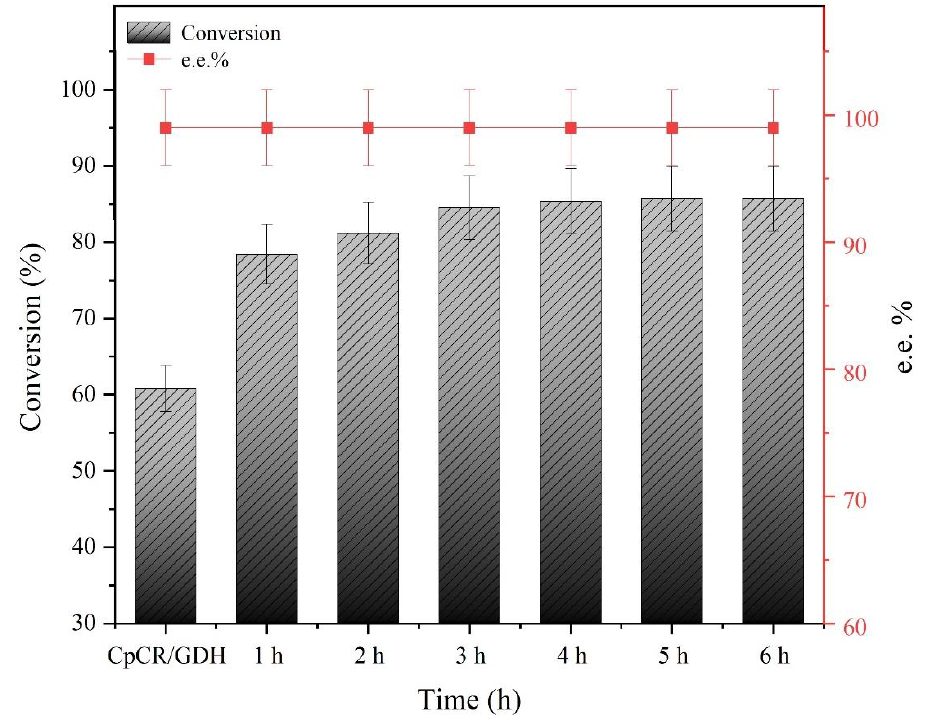
Figure 11. Effect of assembly time on CpCR-SpyCatcher-SpyTag-GDH.